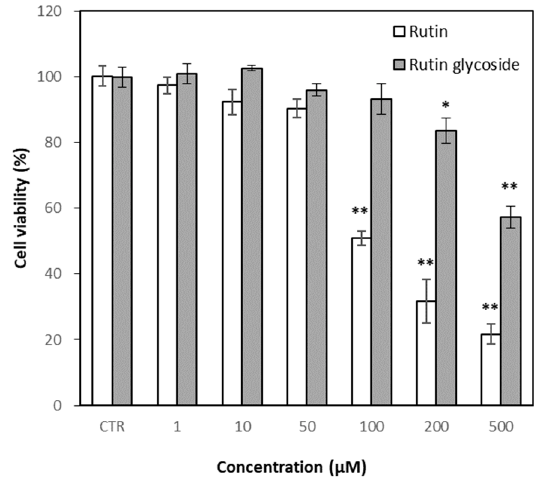
Figure 5. Effect of rutin and rutin glycoside on cell viability. RAW 264.7 cells were treated with rutin and rutin glycoside for 1 h, and incubated with LPS (1 µ g/mL) for 24 h. CTR, Control (LPS). Results were represented as mean ± SD ( n = 3). Significant differences from the control (* p < 0.05; ** p < 0.01).